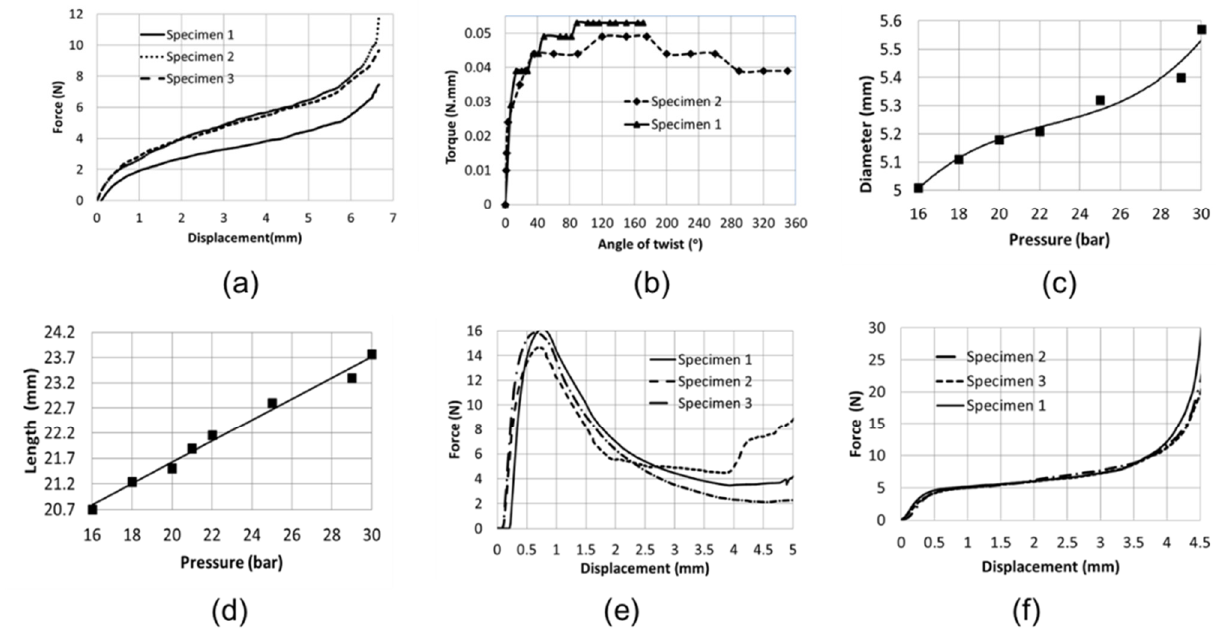
Figure 4. Mechanical test results: ( a ) displacement vs. force under three-point bending; ( b ) angle of twist vs. torque under torsion; ( c ) pressure vs. diameter under radial expansion; ( d ) pressure vs. length under radial expansion; ( e ) displacement vs. force under longitudinal compression; and ( f ) displacement vs. force under lateral compression.